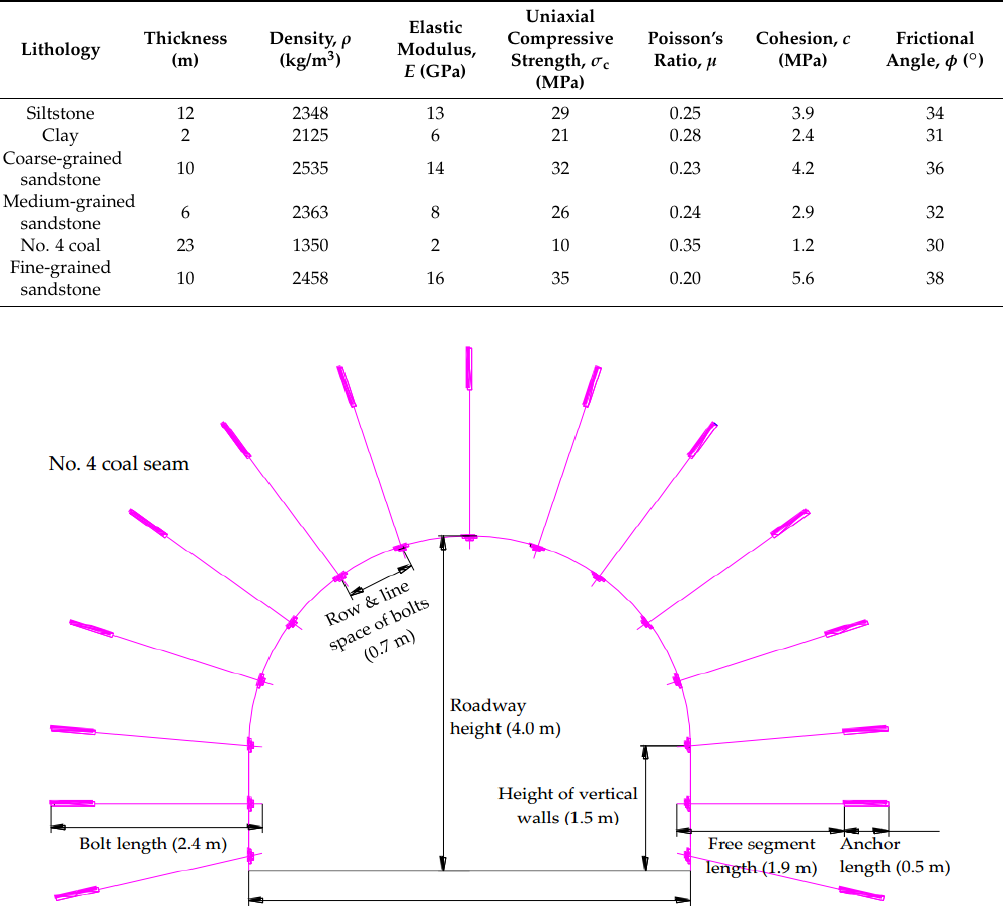
Figure 7. Geologic column of LW402103, showing the geological information (lithology, thickness, depth, age, etc.) for roofs, coal seam and floor. Table 3. Mechanical parameters of coal and rock layers.